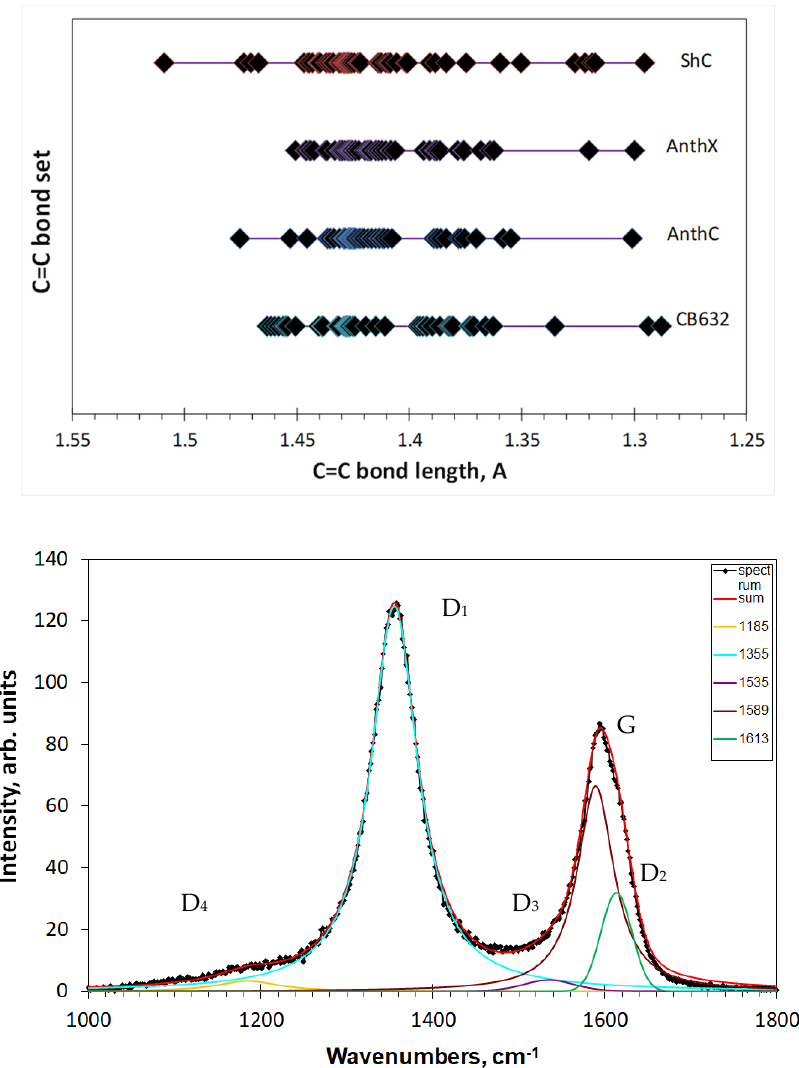
Figure 7. C = C bond sets of the model graphene domains ( top ) and deconvoluted Raman spectrum of shungite carbon ( bottom ) (see text).